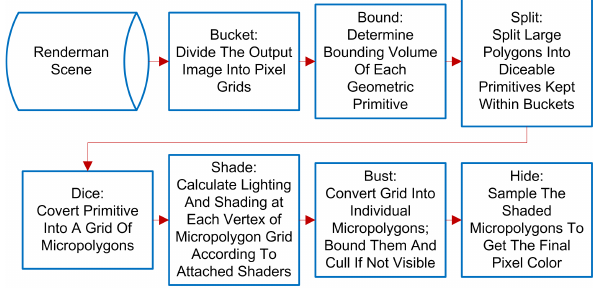
Figure 23 : Chrono ::Render execution workflow.